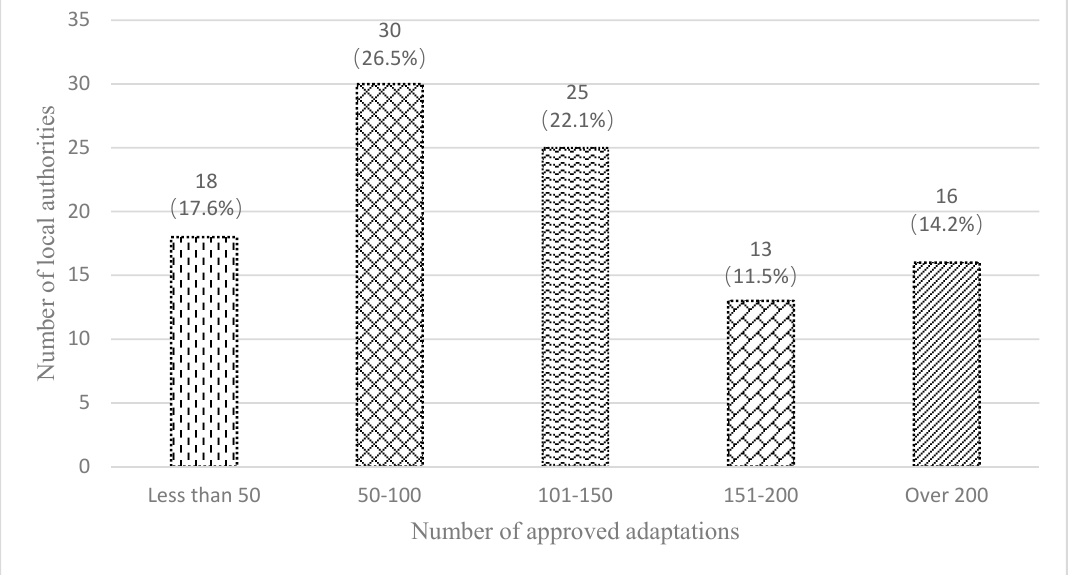
Figure 4. Local authorities completed different levels of adaptations.